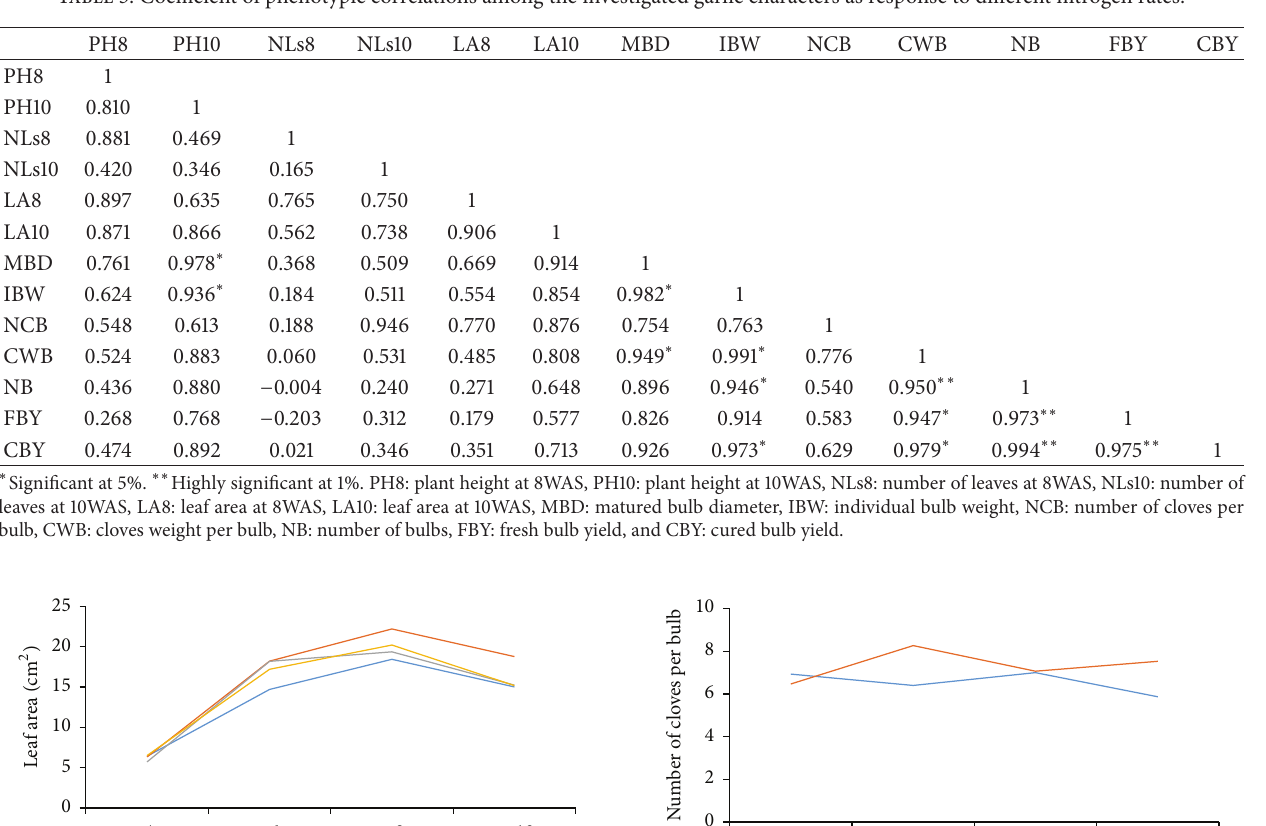
Table 3: Coefficient of phenotypic correlations among the investigated garlic characters as response to different nitrogen rates.